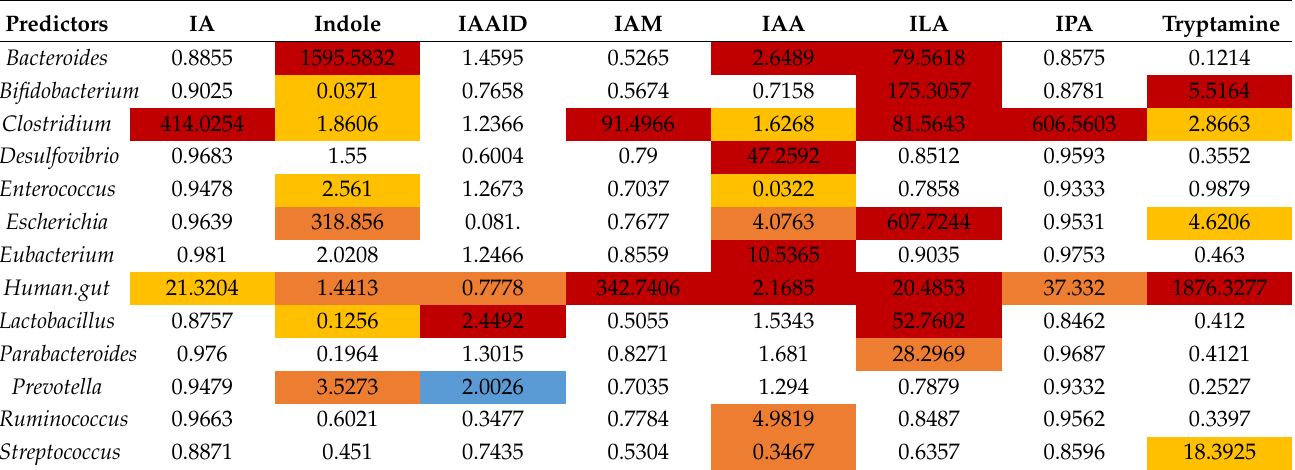
Table 2. Odds ratio of dominate genera in human gut for bioactive indole generation